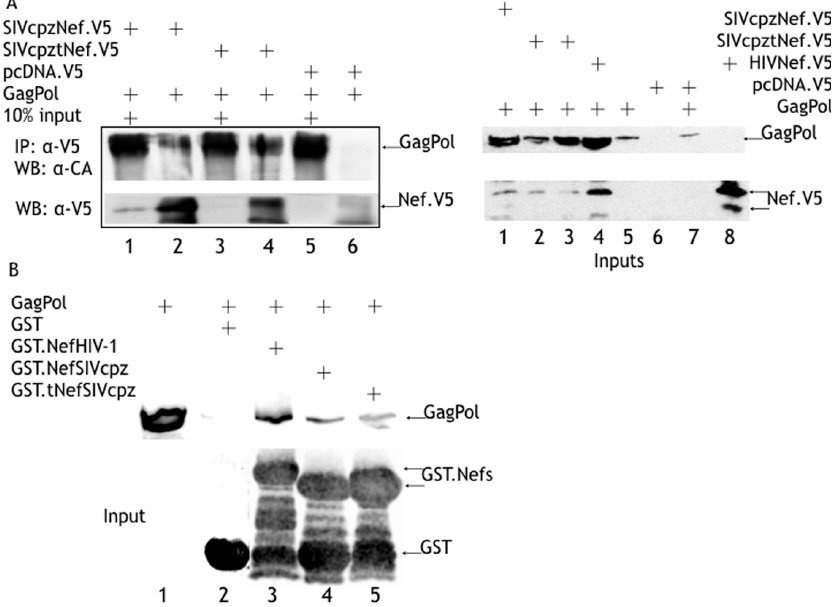
Figure 4. The SIVcpz-Nef protein and the tNef truncated peptide bind to the HIV-1 GagPol polyprotein precursor. ( A ) Hek-293T co-expressing the V5-tagged SIVcpz-Nef protein or the V5-tagged SIVcpz-tNef truncated peptide and a protease-mutated HIV-1 GagPol polyprotein were collected 24 h after transfection; lysates were prepared in RIPA buffer, clarified by low speed centrifugation and immunoprecipitated with anti-V5 antibody followed by protein A/G. Precipitates were washed several times with high salt RIPA buffer. Western blotting of the immunoprecipitates revealed that GagPol was recovered when either SIVcpz-Nef protein or SIVcpz-tNef truncated peptide were present, but not when a pcDNA.V5 empty vector was used; ( B ) GST.SIVcpz-Nef and GST.SIVcpz-tNef fusion protein were purified by glutathione S-transferase columns and incubated with lysates of Hek-293T expressing protease-mutated HIV-1 GagPol polyprotein. Eluates were run in SDS-PAGE, and GagPol was detected by WB with the α -RT antibody. The direct binding of SIVcpz-Nef protein and SIVcpz-tNef truncated peptide to GagPol was confirmed.